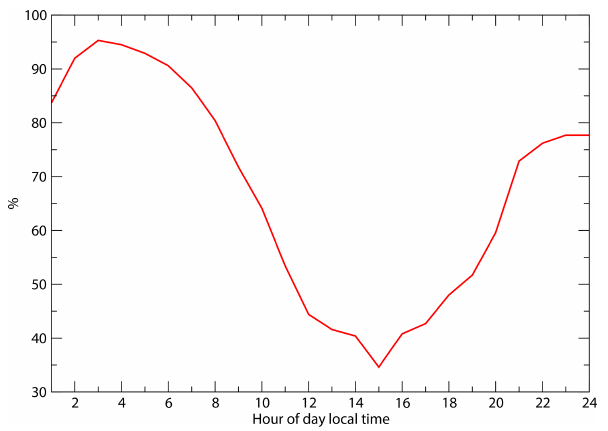
Figure 12. Frequency distribution of occurrences of RHl at the three levels on the tower for the period from 2018 to